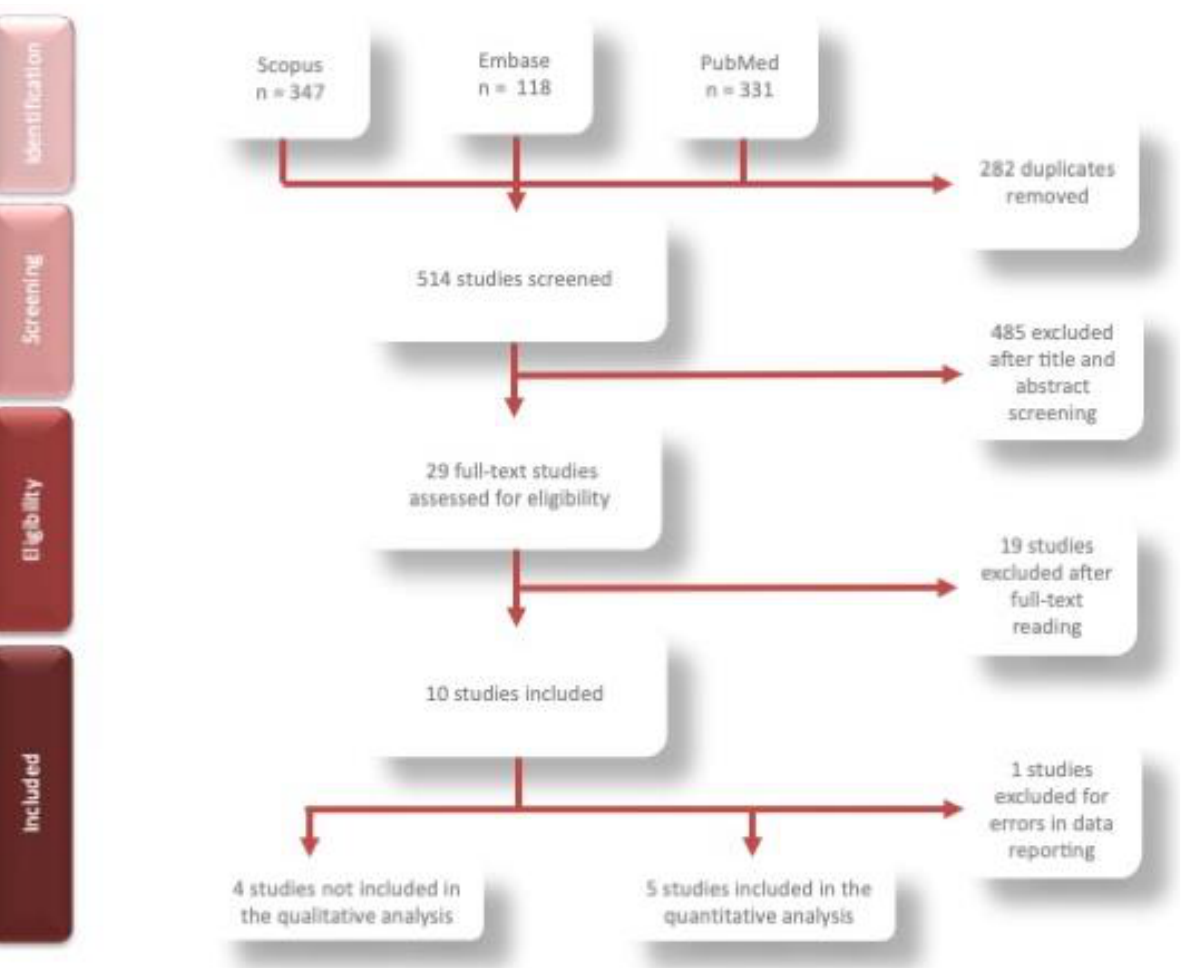
Figure 1. Flowchart of the search strategy and process of the identification of the papers included.